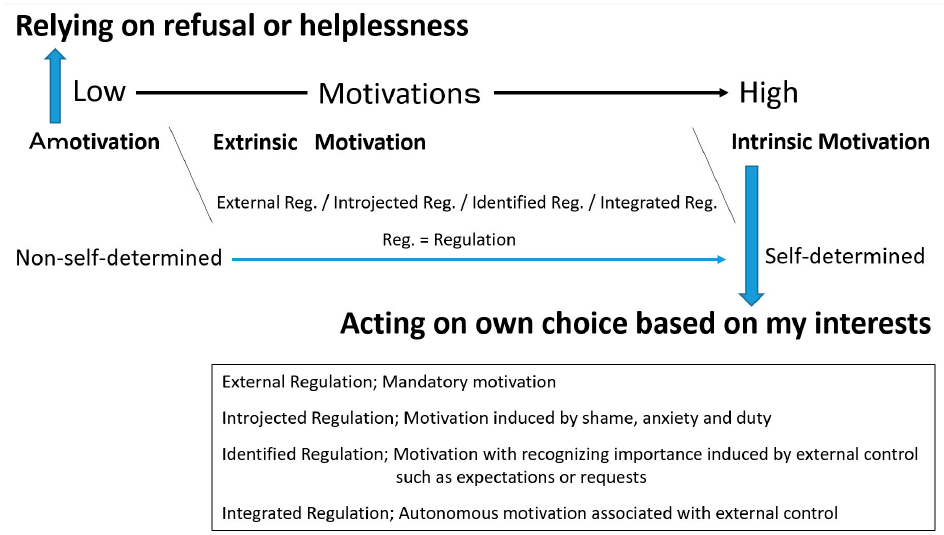
Figure 14. Extrinsic and intrinsic motivation.